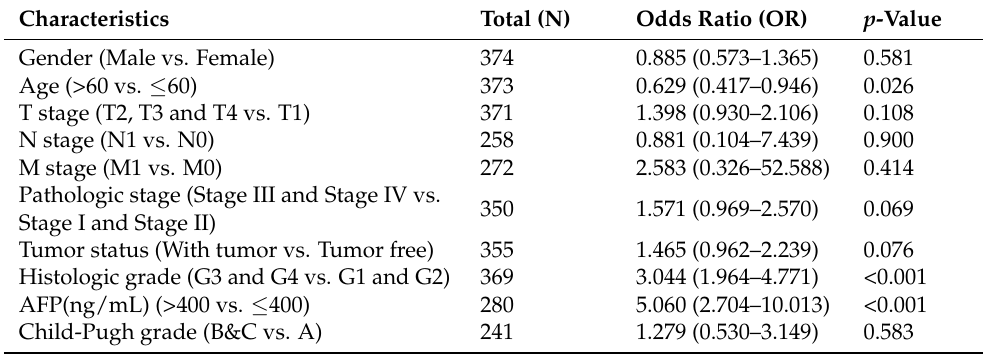
Table 1. Associations of RPS24 expression with the clinicopathologic parameters of HCC patients. Characteristics Total (N)